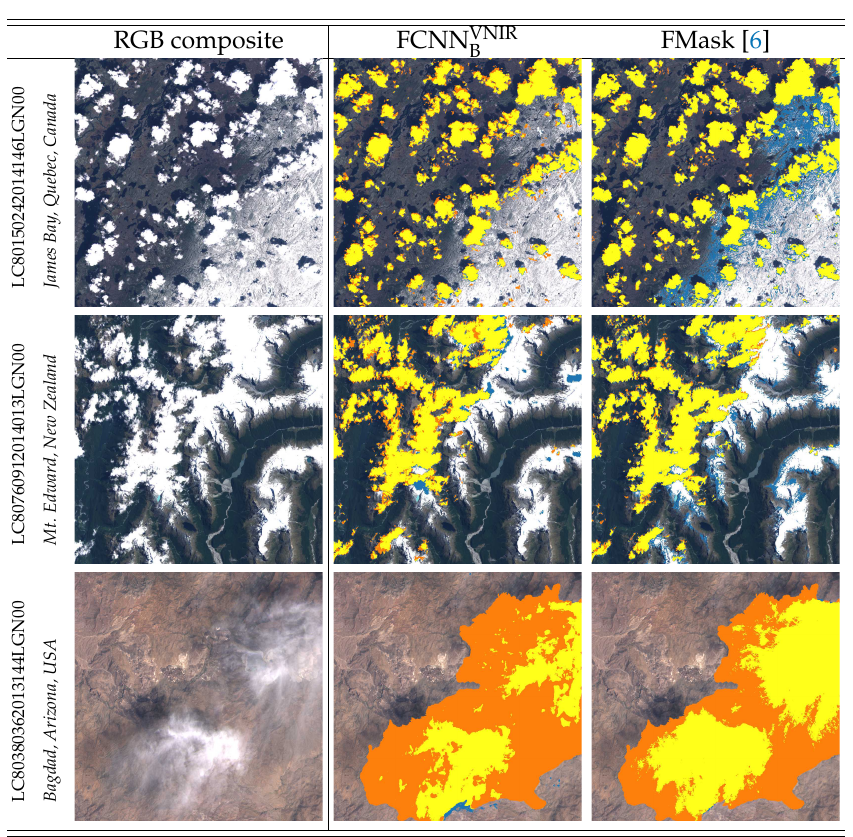
Figure 4. Visual differences between the ground truth and the obtained cloud masks (FCNN VNIR and FMask) over three scenes from the L8-SPARCS dataset. Each row displays a different scene, and models are arranged in columns. The first column shows RGB images, and the models are compared from the second to last columns. Differences are shown, composed of three different colors. Surface reflectance is shown for pixels identified as clear in both the ground truth and predicted cloud